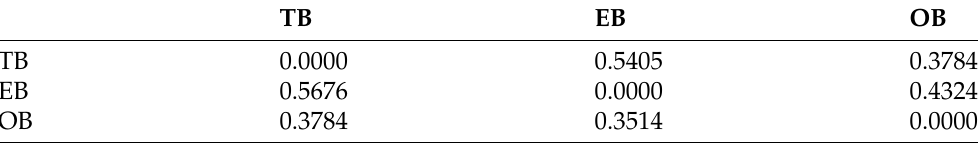
Table 11. Normalized direct-relation matrix (N).